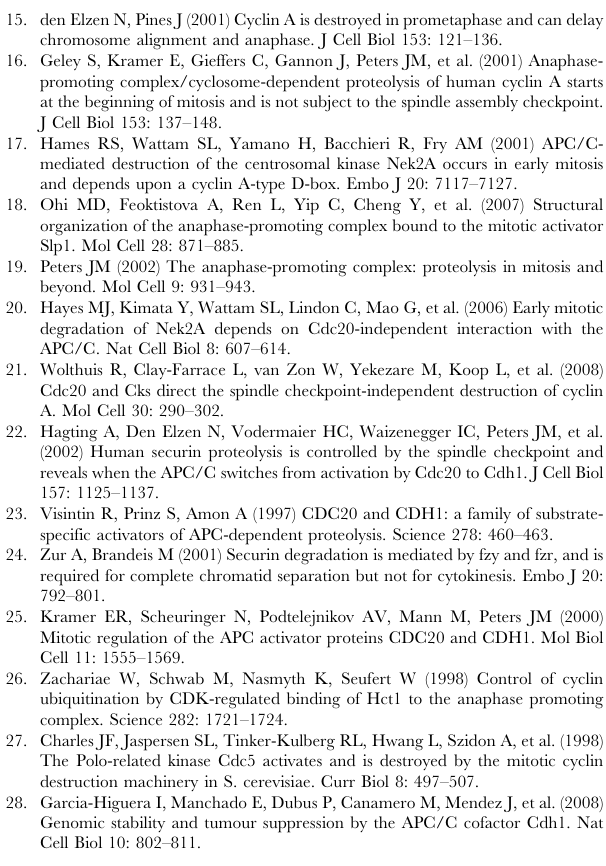
Figure S2 A. U2OS cells were transiently transfected with 1 m g of indicated GFP-Cdc14A phosphorylation mutants. 48 h after transfection, cells were fixed and stained for